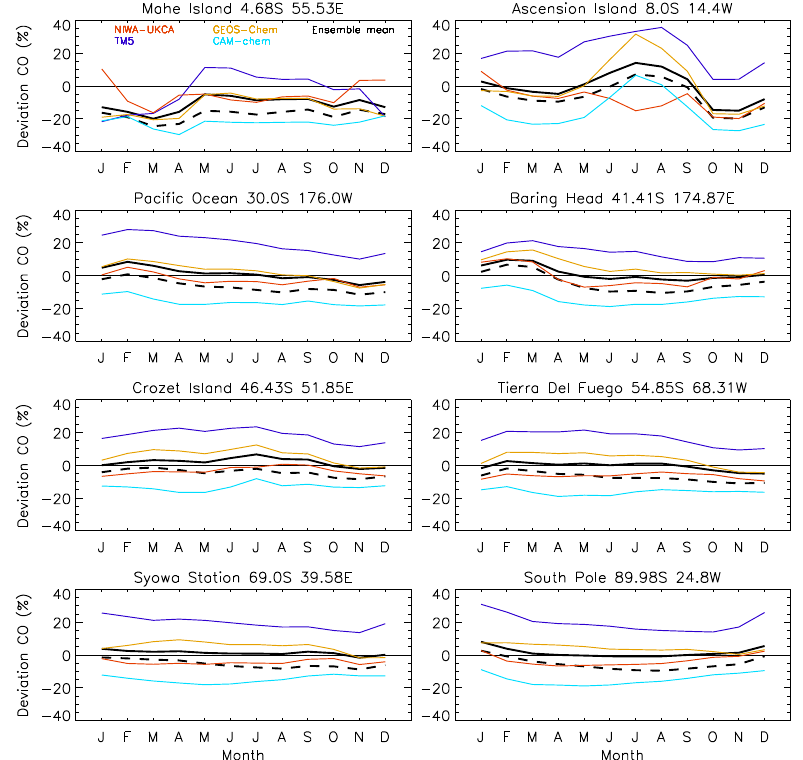
Figure 8. Percentage differences between monthly mean modelled and observed surface CO; solid black lines for CLM-MEGANv2.1 ensemble and dashed black lines for LPJ-GUESS ensemble. Individual model deviations (coloured lines) are from the CLM-MEGANv2.1 simulations only. Data are averaged over 2004–2008.